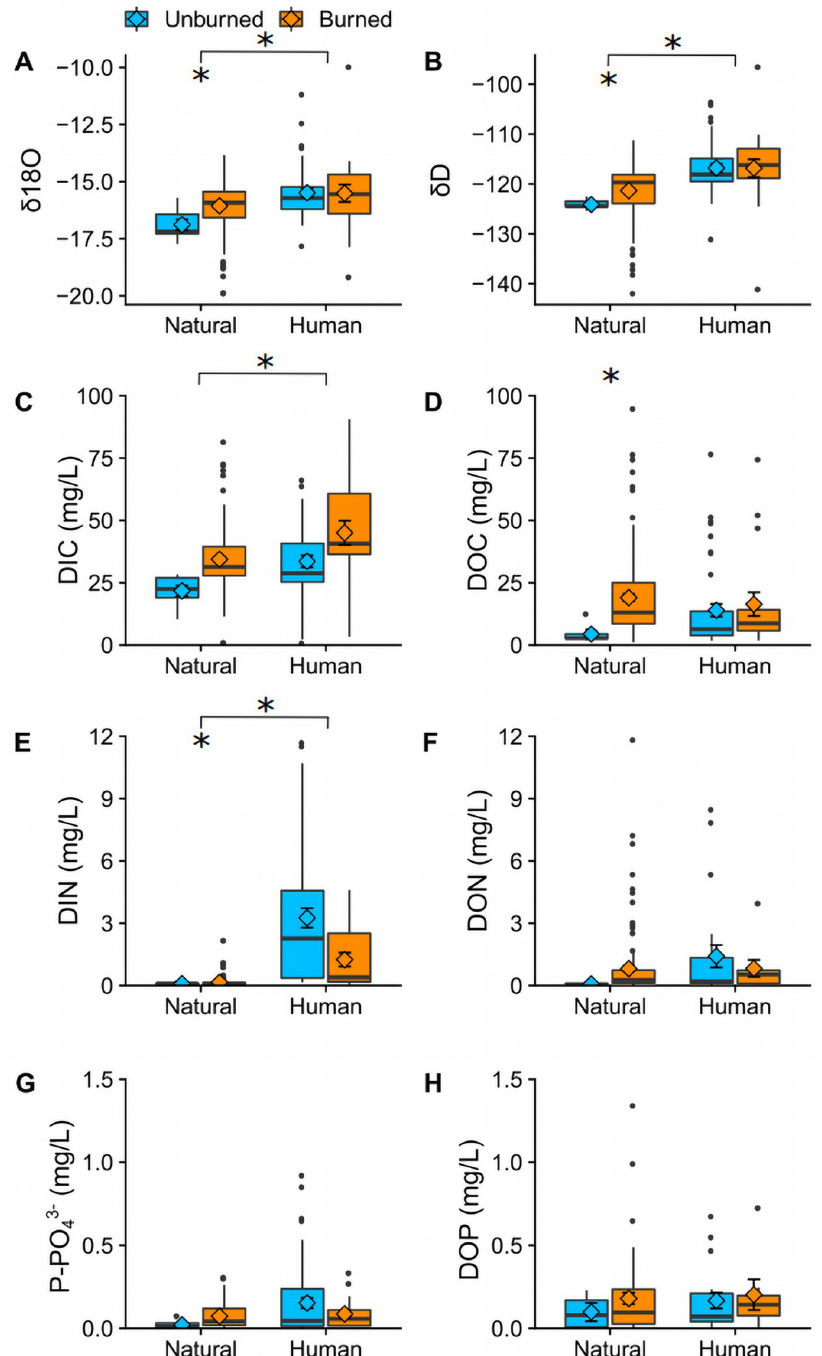
Fig 3. Water isotopes and carbon, nitrogen, and phosphorus species during the observation period categorized by burn status and land use. Statistically significant differences denoted by an � . A-B) Water isotopes, C-D) Dissolved inorganic and organic carbon, E-F) Dissolved inorganic and organic nitrogen, G-H) Phosphate and dissolved organic phosphorus.